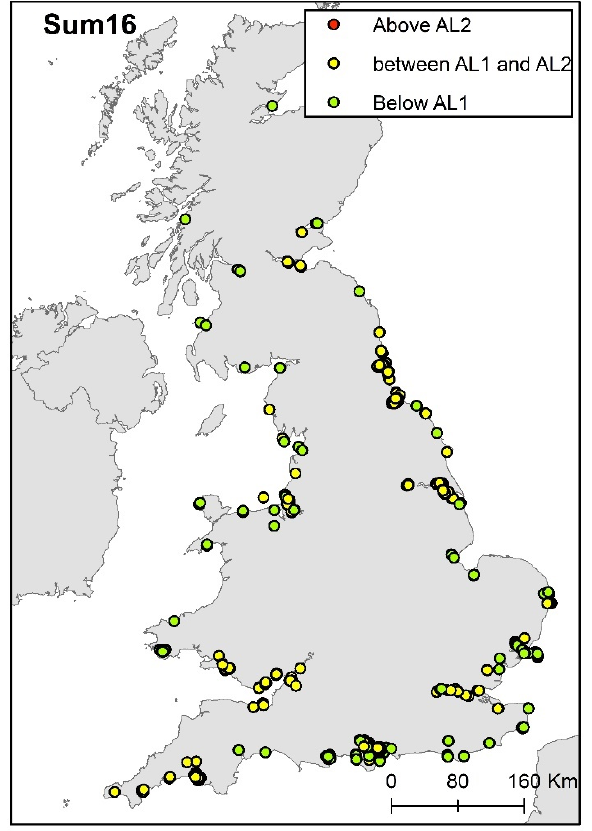
Figure 9. Maps showing summed 16PAHs [17] (Table 13). Samples above AL2 are indicated in red. Figure adapted from [13].